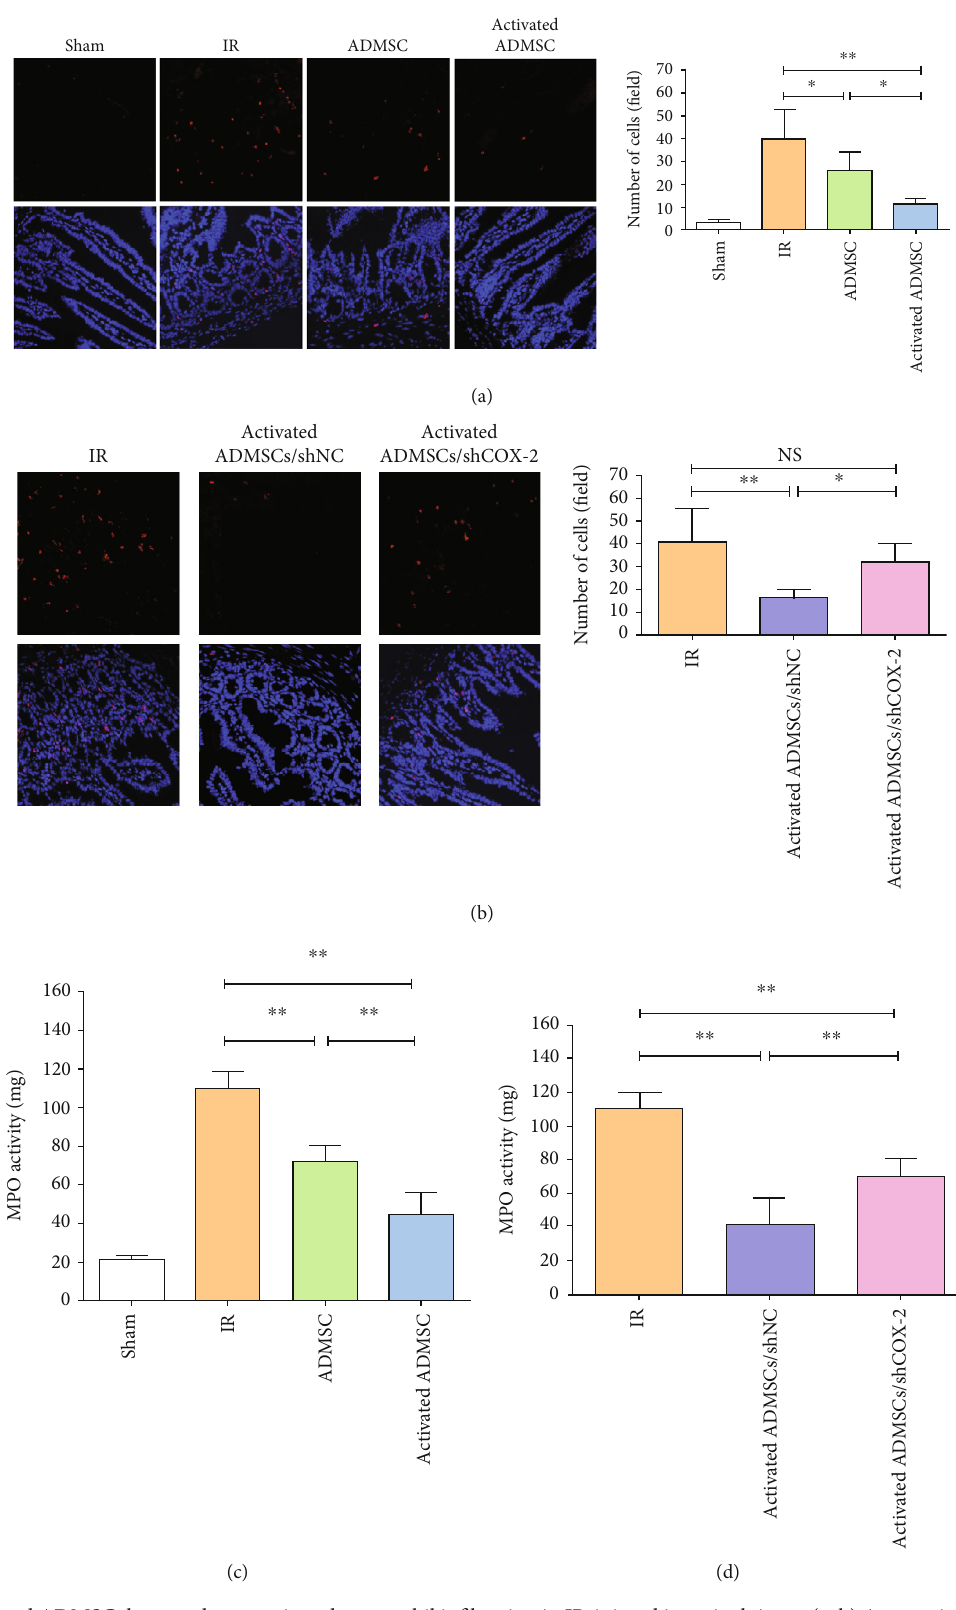
Figure 4: Activated ADMSC decreased apoptosis and neutrophil in fi ltration in IR-injured intestinal tissue. (a, b) Apoptosis was evaluated by TUNEL staining for di ff erent groups. (c, d) Neutrophil in fi ltration was assessed by MPO activity ( ∗ P < 0 : 05 , ∗∗ P < 0 : 01 , NS: no statistical signi fi cance, Bonferroni ’ s multiple